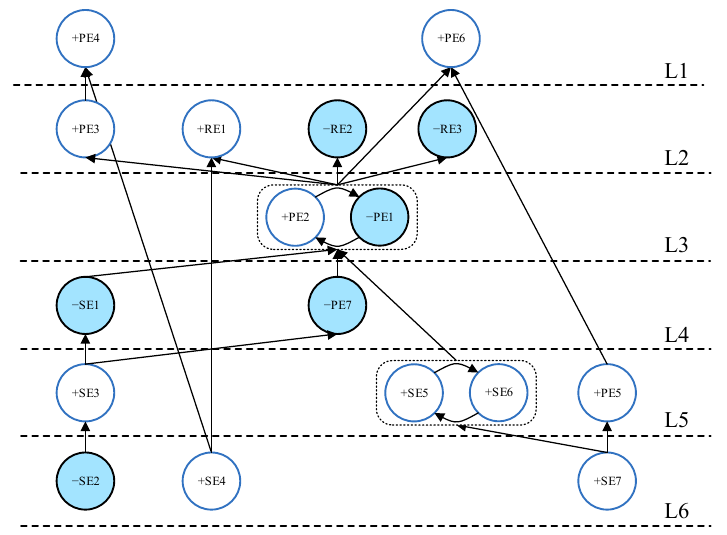
(cid:12) (cid:12) (cid:12) (cid:12) > 3.03. (cid:12) C ij (cid:12)